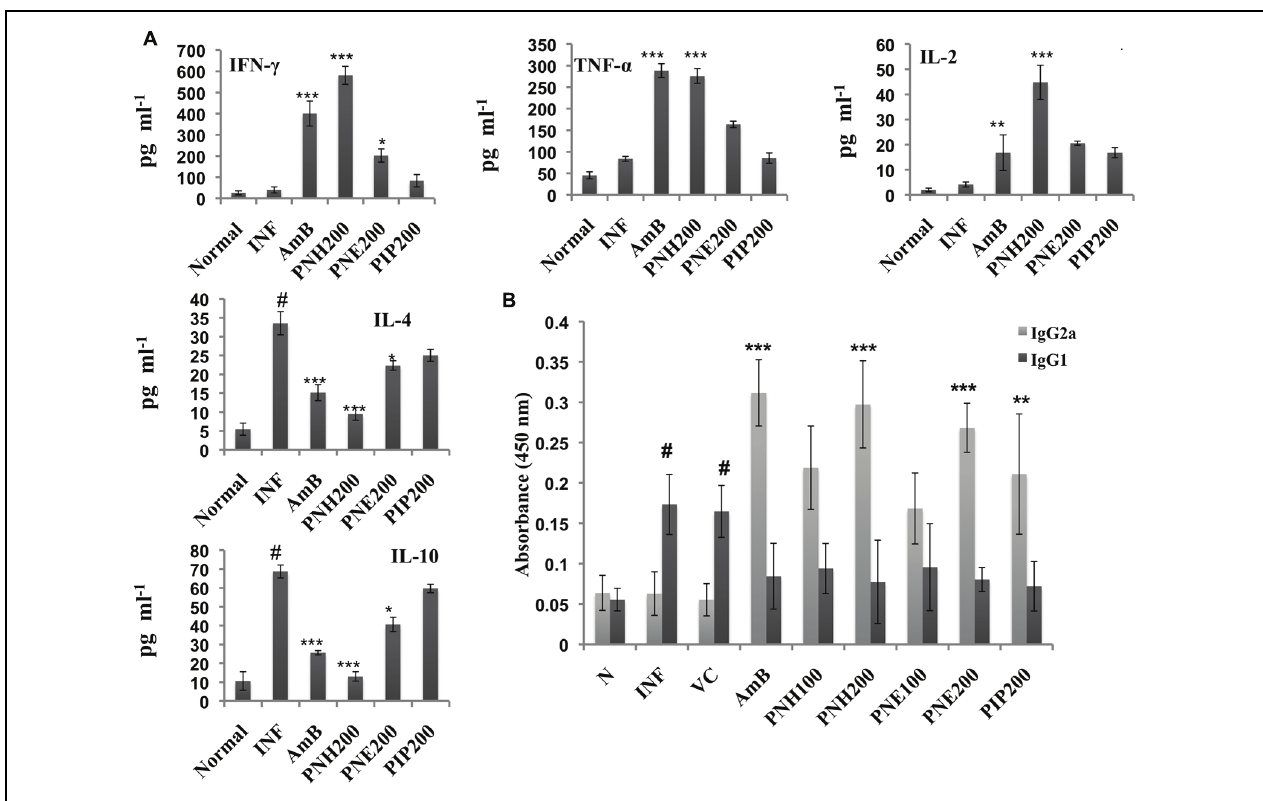
FIGURE 8 | Analysis of Th1 subset potentiation. (A) Estimation of Th1 and Th2 cytokine levels. INF- γ , TNF- α , IL-2, IL-4, and IL-10 were quantified in culture supernatants of splenocytes post 48 h of SLA stimulation as described in the Section “Materials and Methods”. # P < 0.001 in comparison to normal group, ∗∗∗ P < 0.001, ∗∗ P < 0.01, and ∗ P < 0.05 with respect to INF. (B) IgG isotyping in sera of untreated and differently treated BALB/c mice. Leishmanial antigen specific IgG2a and IgG1 isotypes were quantified in BALB/c mice serum samples by ELISA. #,indicates significant elevation in IgG1 levels in INF and VC group in comparison to naïve mice. ∗∗∗ P < 0.001, and ∗∗ P < 0.01 with respect to